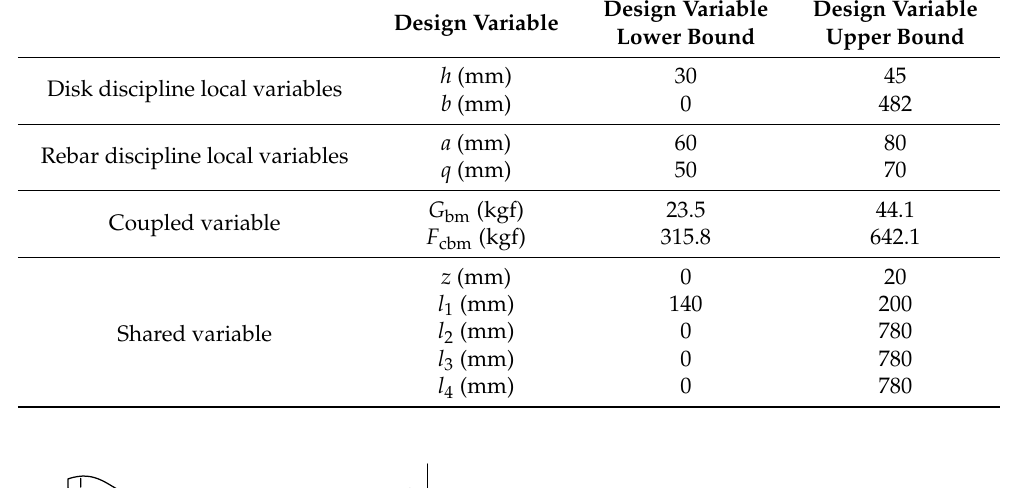
Table 1. Variable information in the rotor mechanism design optimization problem.